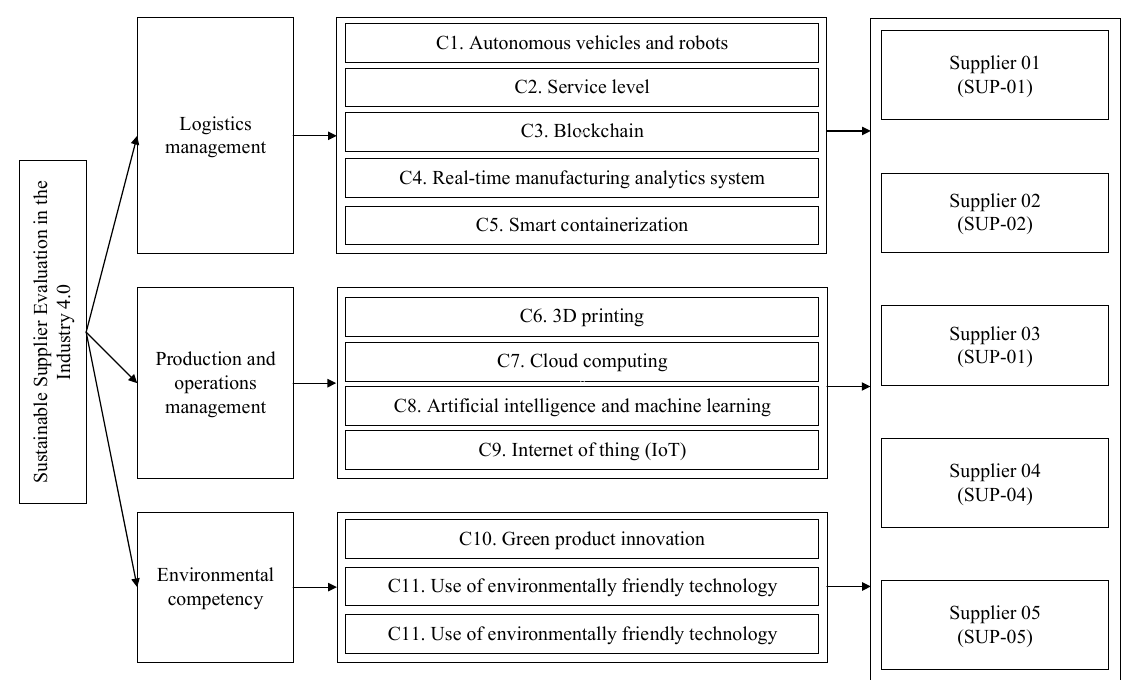
Figure 2. The decision tree.